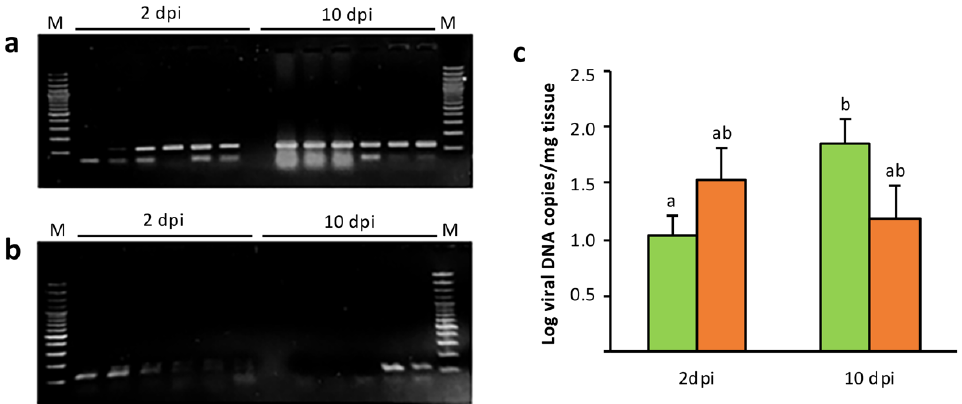
Figure 3. Viral detection in caudal fin samples of gilthead seabream at 2 and 10 days post-inoculation (dpi). LCDV-Sa challenges were carried out in fish 21 days after injection of ( a ) pcDNA (mock-vaccinated fish), and ( b ) pcDNA-MCP (vaccinated fish). M, molecular weight marker (100 bp DNA ladder). ( c ) Viral loads (mean ± SEM) in LCDV-Sa positive samples from mock-vaccinated (green) and vaccinated (orange) fish. Different letters denote significant differences between groups and time points analyzed ( p < 0.05).